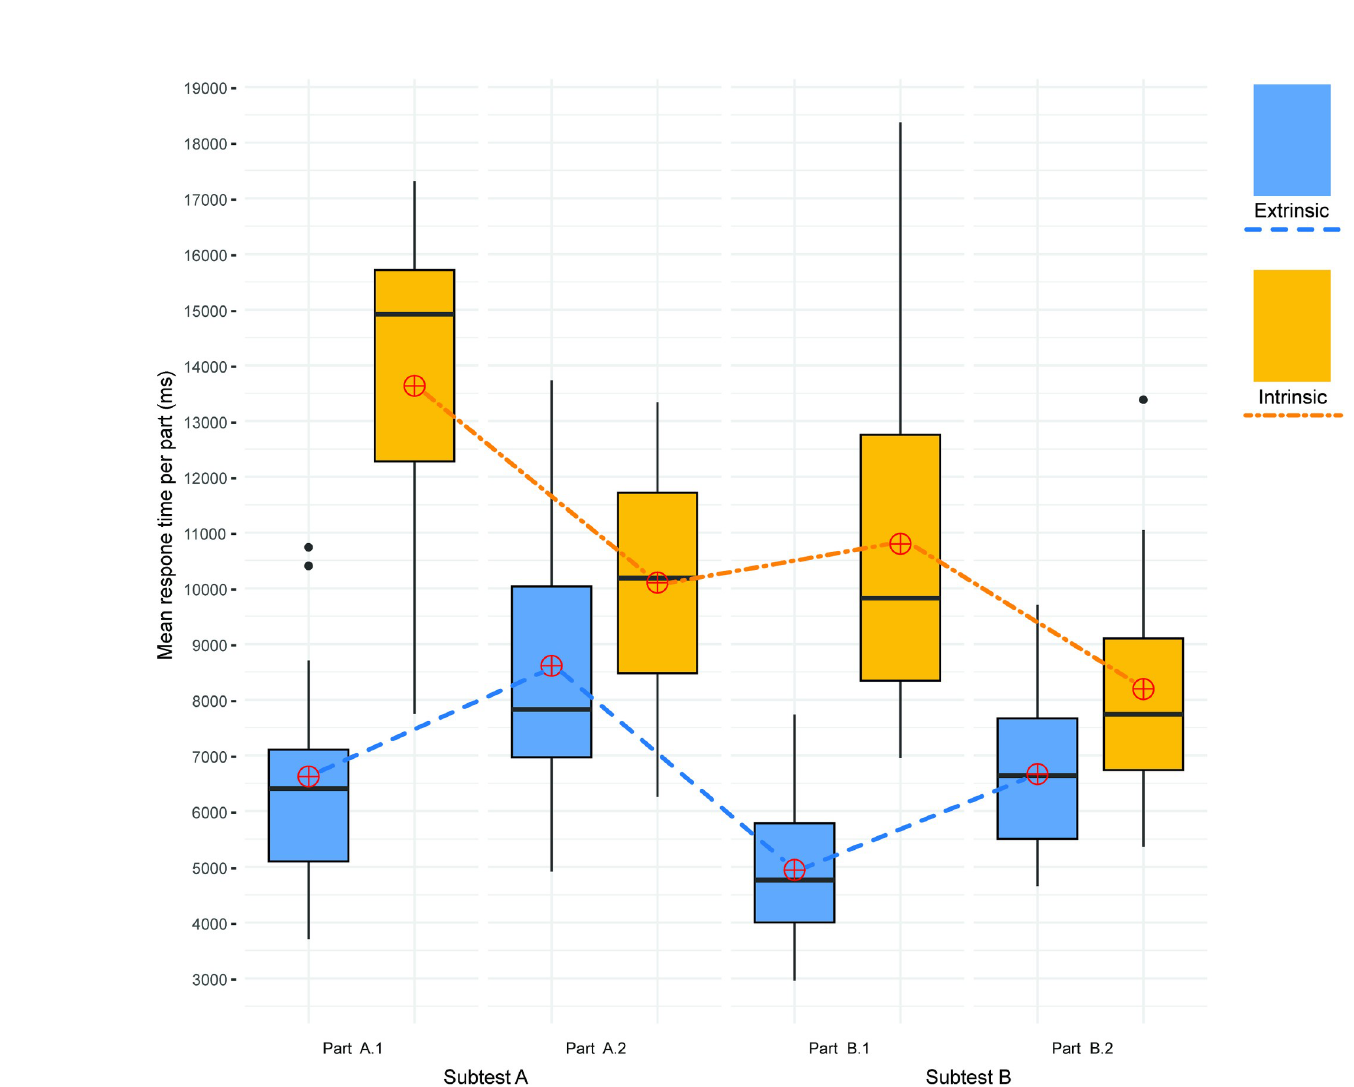
Fig 9. Mean response time (ms) per item (calculated for the individual subtest levels).